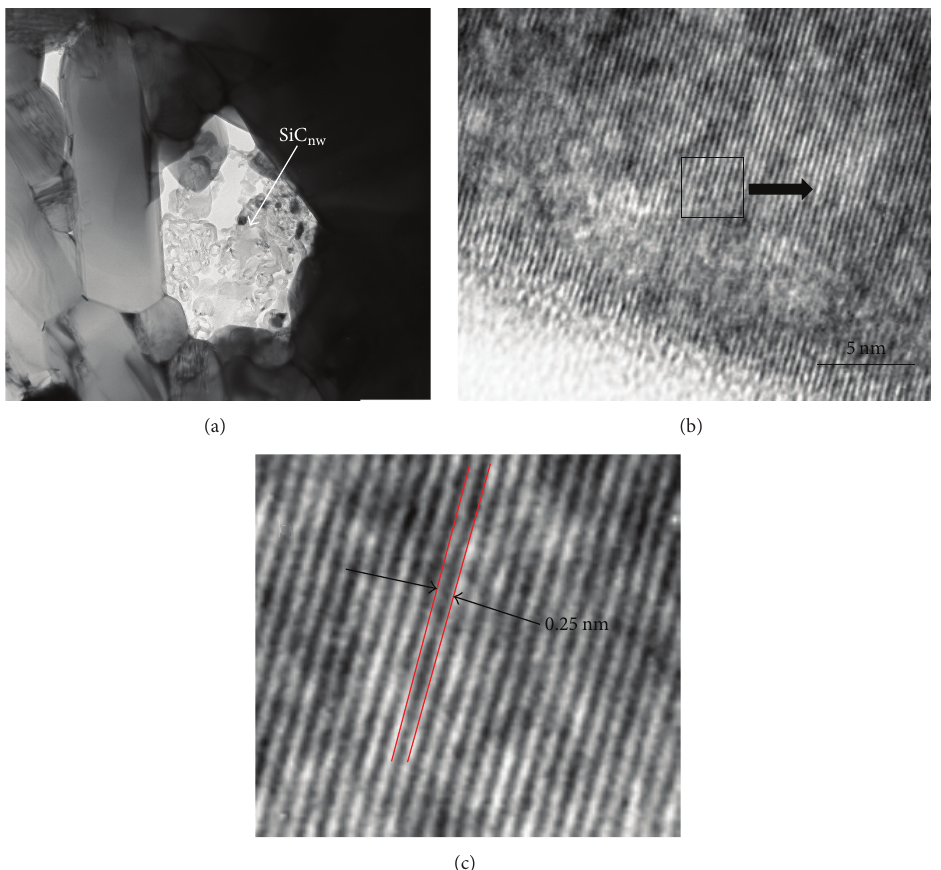
Figure 5: TEM photos of AM60 specimen, (a) and (b) high resolution image and (c) local